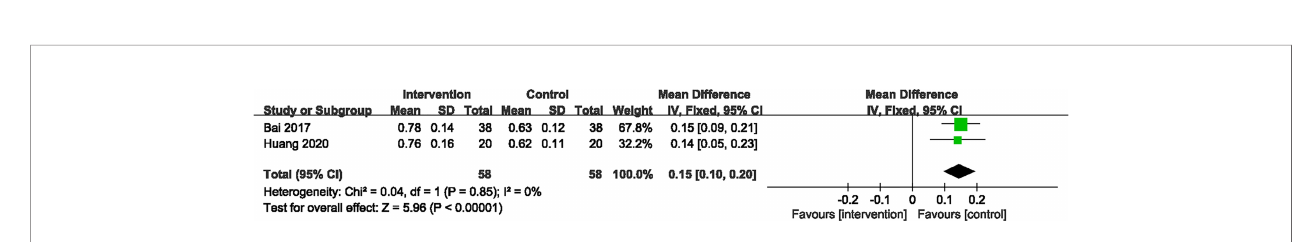
FIGURE 6 | Forest plots of comparison of visual acuity for CPMs plus CD versus CD alone.